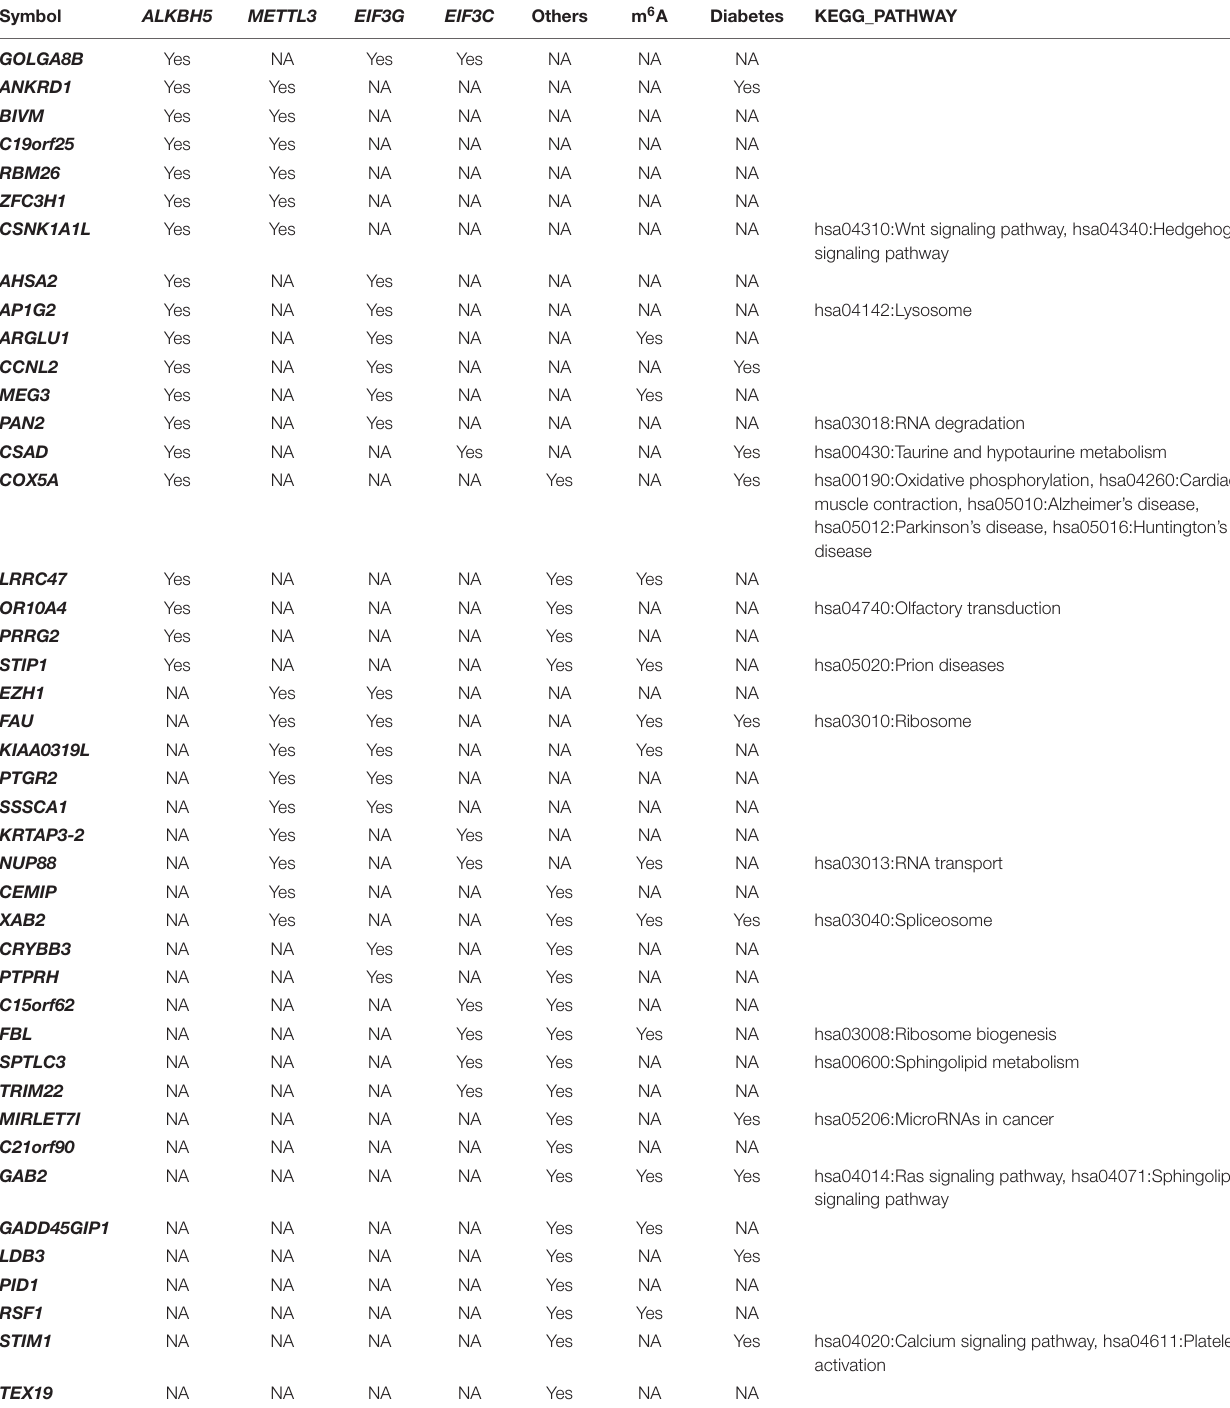
TABLE 1 | Typical genes co-expressed with m 6 A regulators in T2DM. Symbol ALKBH5